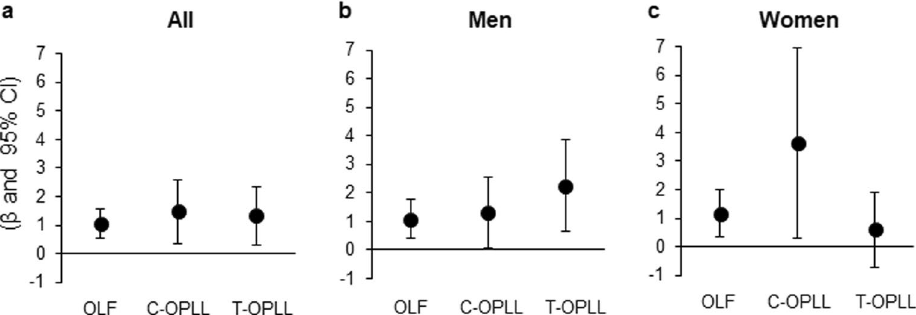
Figure 4. Comparison of the correlation of dyslipidemia with OLF, C-OPLL, and T-OPLL. Results shown are β-values with 95% CIs (error bars). ( a ) All subjects. ( b ) Men. ( c ) Women. OLF, ossification of the ligamentum flavum; OPLL, ossification of the posterior longitudinal ligament; β, regression coefficient; CI, confidence interval; C, cervical; T,